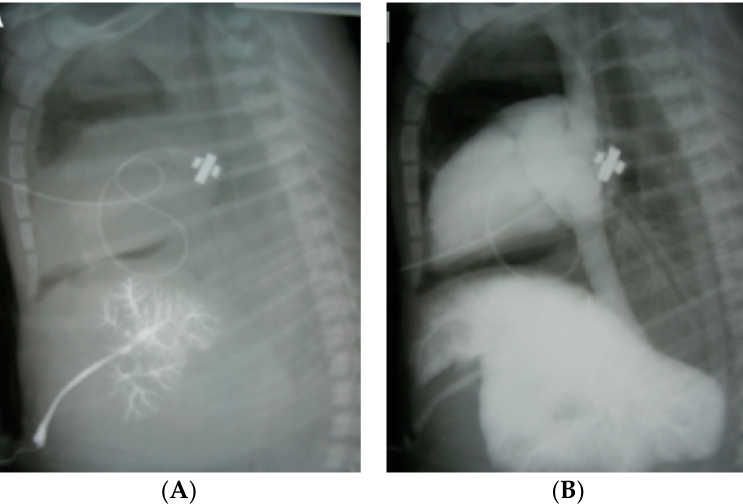
Figure 6. X-ray showing distribution of contrast following low- and high-volume flush through a low-lying umbilical venous catheter following 30 sec of chest compressions in term cardiac-arrested lambs. ( A ) Administration of 1 ml flush of Omnipaque shows the contrast remained in the portal venous system. ( B ) Increasing the Omipaque flush solution to 10 ml resulted in a much better distribution of contrast into the heart and great vessels. Copyright Satyan